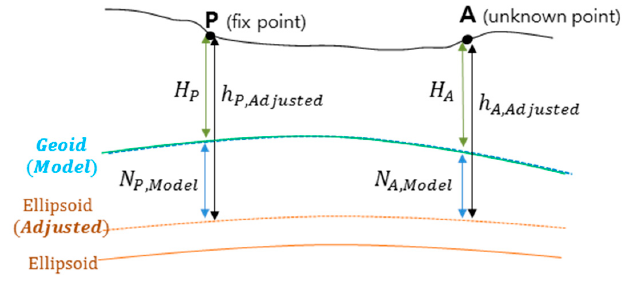
Figure 1. Concept of GNSS-derived height determination [10].